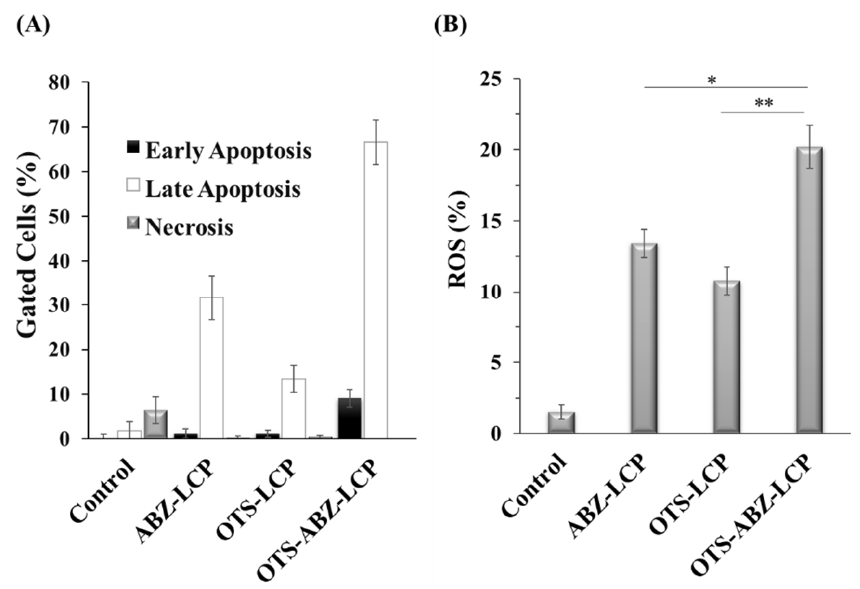
Figure 3. Determination of apoptosis and ROS generation . ( A ) Annexin V-FITC/PI double staining analysis of apoptosis in B16F0 cells treated with ABZ-LCP, OTS-LCP and OTS-ABZ-LCP NPs for 24 h; ( B ) Fluorescence intensity of oxidized DCFDA as a marker of ROS overproduction in B16F0 cells with no treatment, treated with ABZ-LCP, OTS-LCP and OTS-ABZ-LCP NPs for 24 h and followed by incubation with DCFDHA for 30 min. Drug doses: 2.5 µ g/mL of ABZ and/or 64 ng/mL of OTS964. Data are presented as mean ± SEM (n = 3–5).